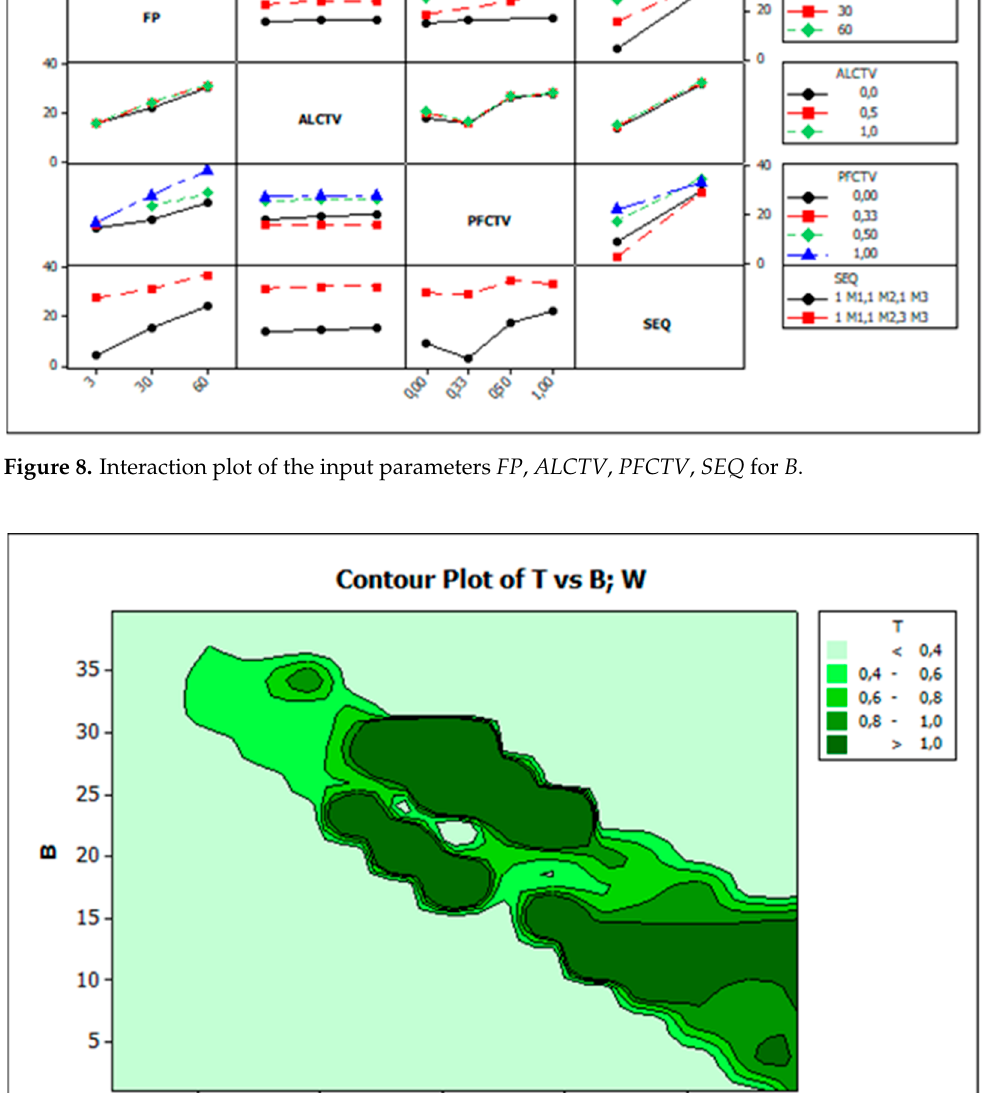
Figure 9. Contour plot of T versus B and